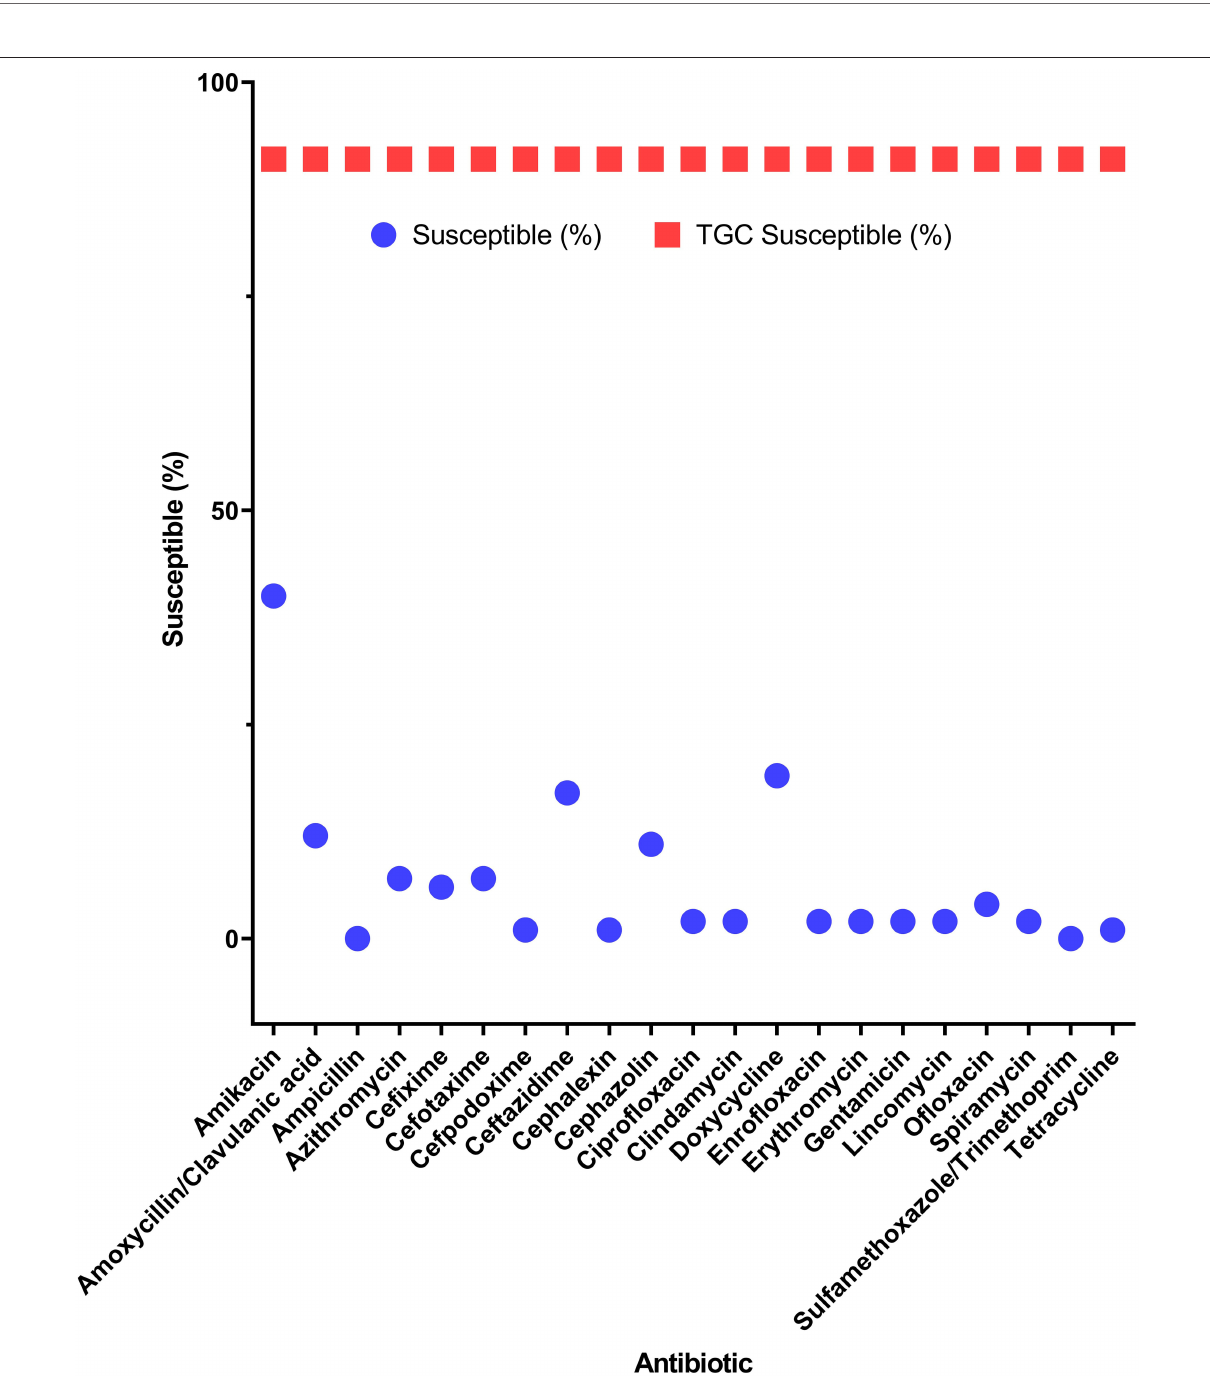
(60.8%) were XDR, and 40 (27.9%) were potential PDR bacteria ( Supplementary File 1 ). Of note, 82.5% (33/40) of the potential PDR gram-negative isolates were sensitive to TGC. The average inhibition zone diameter was 18.5 mm for positive isolates, which